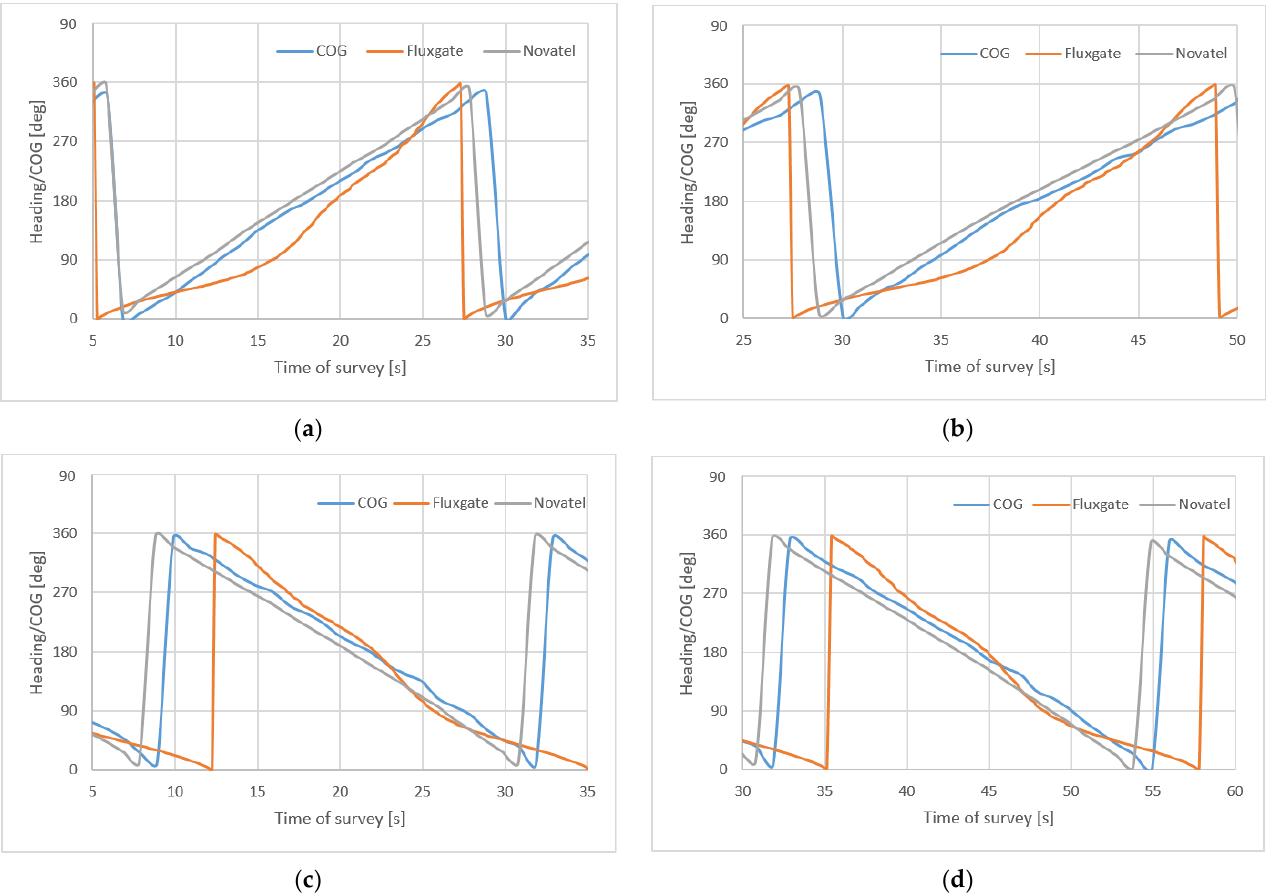
Figure 14. Headings/COG during two rotations right ( a , b ) and left ( c , d ).